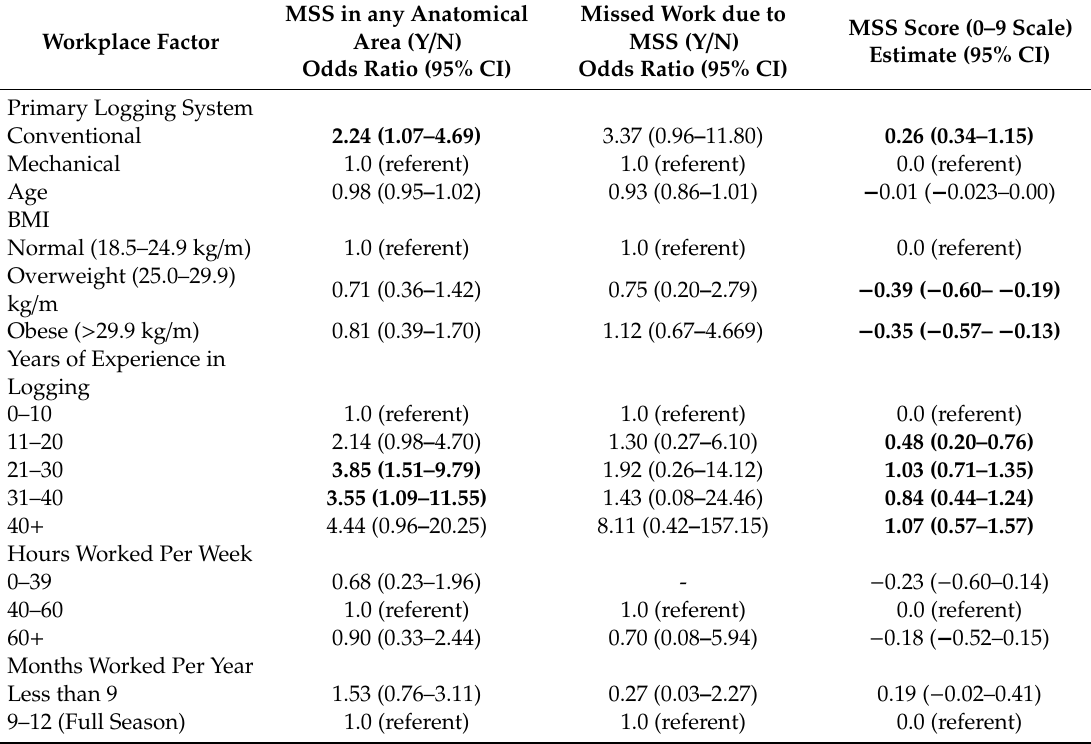
Table 4. The regression results: indicators of MSS in Montana loggers (the bolded values indicate a statistical